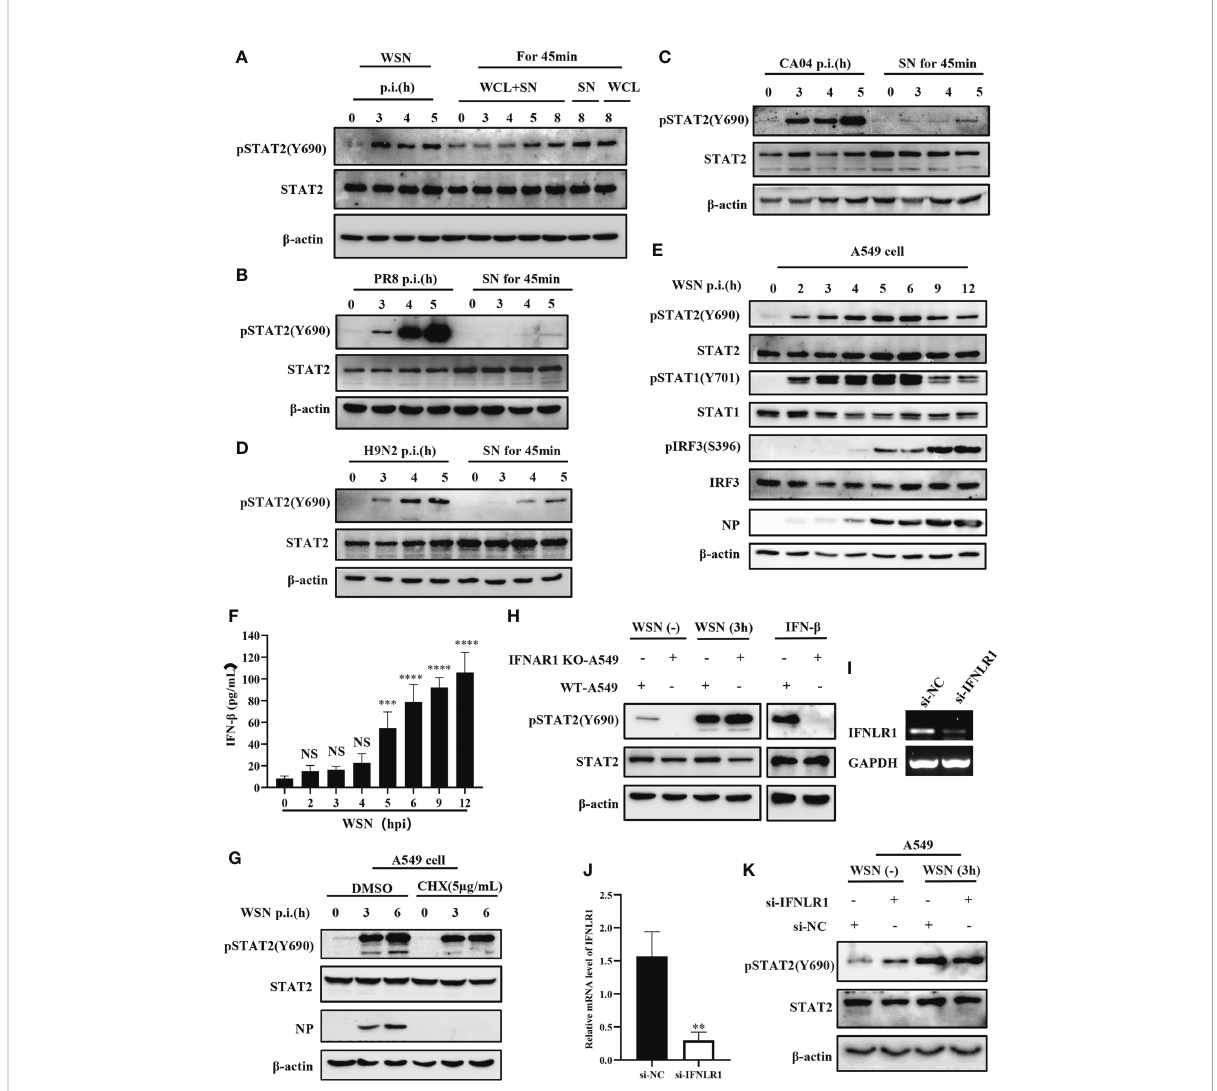
FIGURE 2 Initial activation of STAT2 is independent of type I and type III IFNs signaling at the early viral infection. (A) A549 cells were infected with WSN at the indicated time. Supernatant and whole cell lysate (WCL+SN) at the corresponding time point were collected to stimulate the naive cells for 45min, respectively. In the fi gure, SN and WCL were used as controls for the early phosphorylation of STAT2 Y690. The pSTAT2(Y690) was detected by Western blotting. (B – D) A549 cells were infected with different in fl uenza strains PR8 (B) , CA04 (C) , and H9N2 (D) . Corresponding cell supernatant (SN) cultures were collected to stimulate the naive cells for 45 min, respectively, followed by Western blotting with indicated antibodies. (E, F) A549 cells were infected with WSN for indicated time points. Western blotting analysis was performed to detect the phosphorylation of STAT1, STAT2, and IRF3 (E) . ELISA was employed to examine the protein levels of IFN- b in the SN (F) . (G) A549 cells were treated with DMSO or cycloheximide (CHX) (5µg/mL) for 20 min in advance, then infected with WSN for indicated time. pSTAT2 was detected by Western blotting. (H) IFNAR1 knockout (IFNAR1-KO-A549) or wild-type A549 (WT-A549) cells were infected with WSN for 3 h or treated with IFN- b for 45 min. pSTAT2 was analyzed by Western blotting. (I, J) Si-IFNLR1 or control si-NC was transfected into A549 cells for 24 (h) RT-PCR (I) and RT-qPCR (J) were used to detect the knockdown ef fi ciency. (K) Si-IFNLR1 or si-NC -based A549 cells were infected with WSN for 3 h, and the level of pSTAT2(Y690) was detected by Western blotting. Data represent the mean ± SD from three independent experiments. **p < 0.01. The above results show the representative results of three independent experiments. ***p <0.001; ****p <0.0001; ns, no signi fi